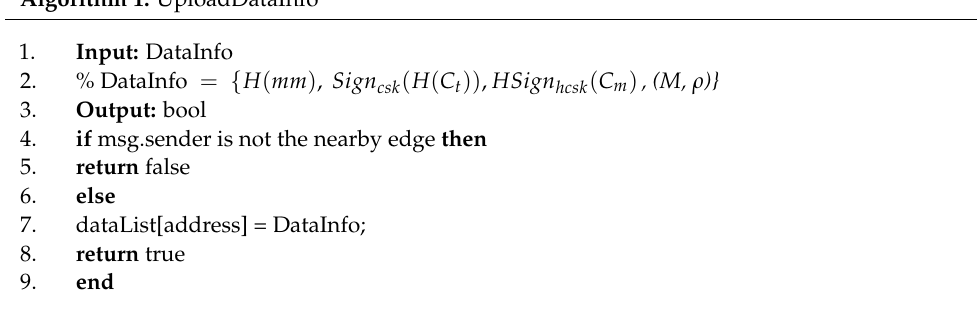
Algorithm 1 . UploadDataInfo